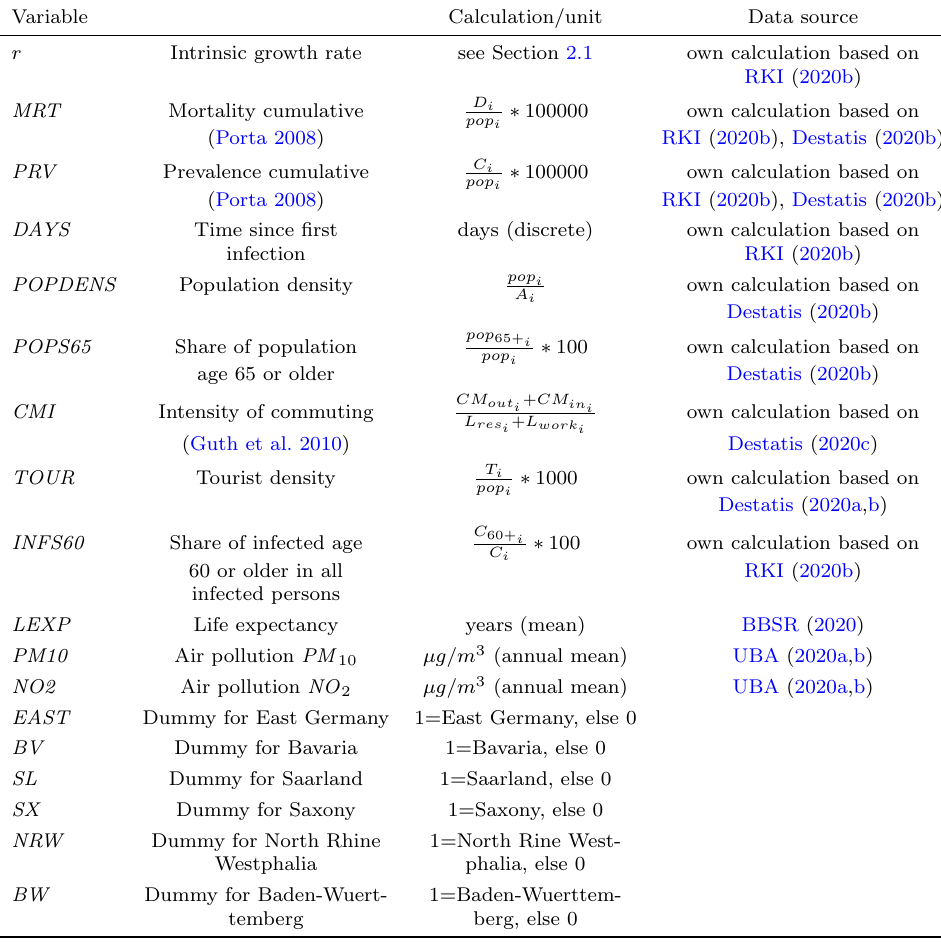
Table 4: Variables in the regression models for growth rate and mortality Variable Calculation/unit Data source Intrinsic growth